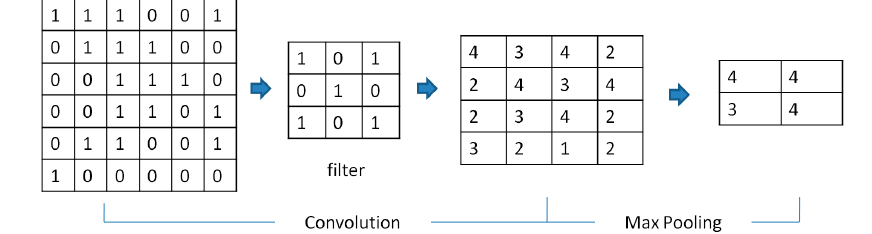
Figure 5. Framework of a general CNN.